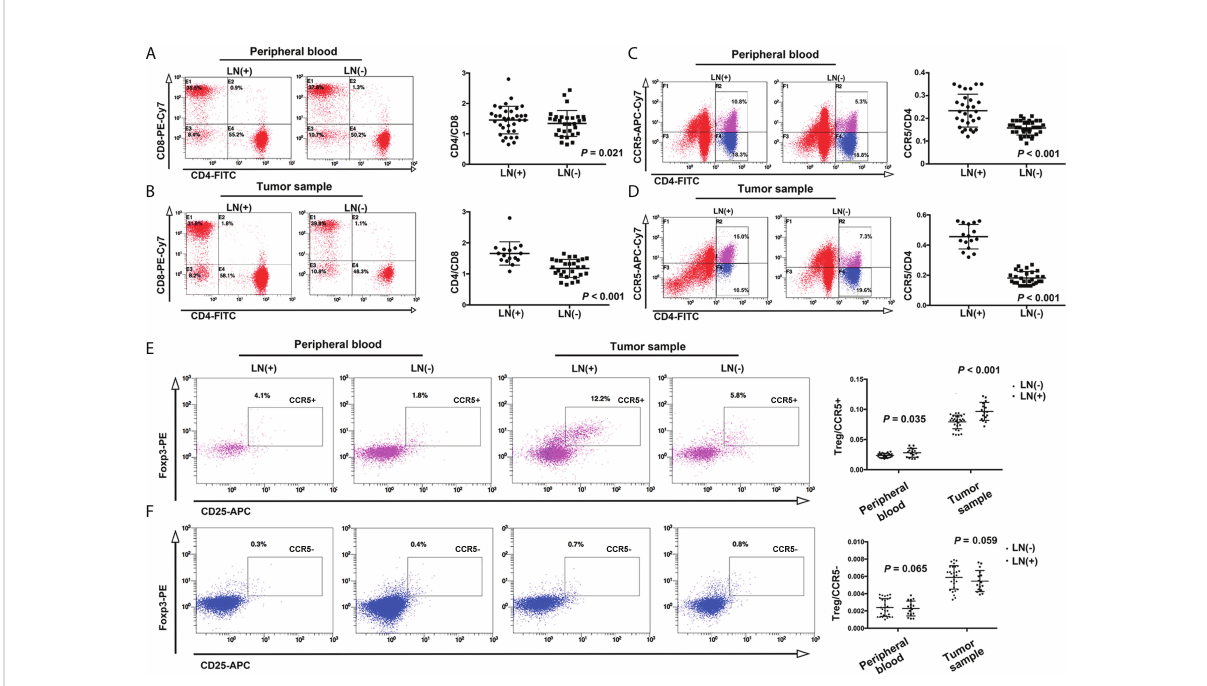
FIGURE 8 In the peripheral blood of patients with axillary lymph node metastasis of breast cancer, the ratios of CD4/CD8 and CCR5/CD4 were higher than in patients without lymph node metastasis (A, C) . This trend was more obvious in tumor tissues and cells (B, D) . (E) The proportion of CD4+CD25+Foxp3+ (Treg cells)/CCR5+ cells in peripheral blood and tumor tissue were higher in the lymph node metastasis group, while the proportion of Treg/CCR5- cells was not signi fi cantly different between the two groups (F)